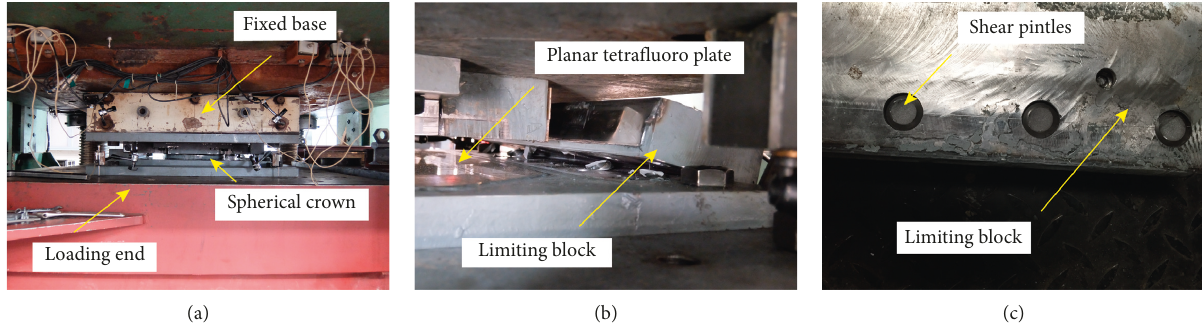
Figure 11: Photographs of the isolation bearing tests. (a) Limited capacity bearing. (b) Loading on the testing machine. (c) Limiting block.